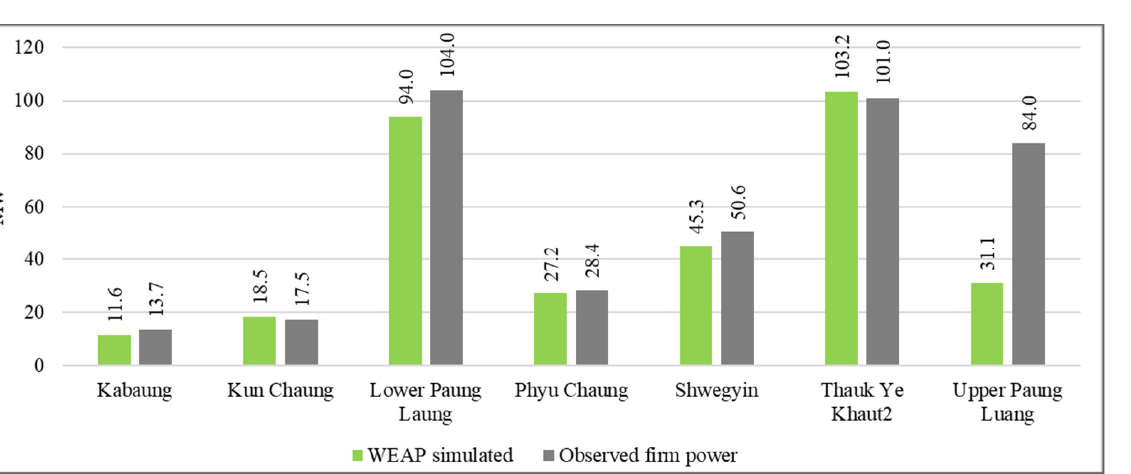
Figure 10. Baseline and projected mean annual flows at the outlet of Sittaung under RCP4.5 and RCP8.5 scenarios. While the mean of all GCMs exhibited a general increase in annual flows in the basin for both RCP4.5 and RCP8.5 scenarios, the monthly mean flow projections of the GCMs showed that some months, such as July and October, might experience some decrease (Table 8). This expectation was due to the decrease in rainfall during these months (Table 5). However, flows increased in December and January (nearly 100%) under all scenarios of climate change, whereas the rainfall during these months was expected to go under the baseline due to the presence of reservoirs in the basin. Moreover, the agreement among GCMs was very high (Table 8) in predicting the direction of the change of flows during